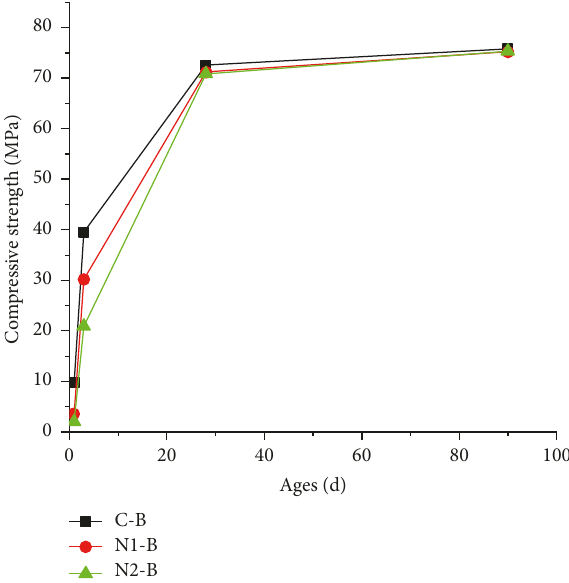
Figure 14: Pore structures of the steam-cured hardened paste with W/B of 0.4 at the age of 90 d.